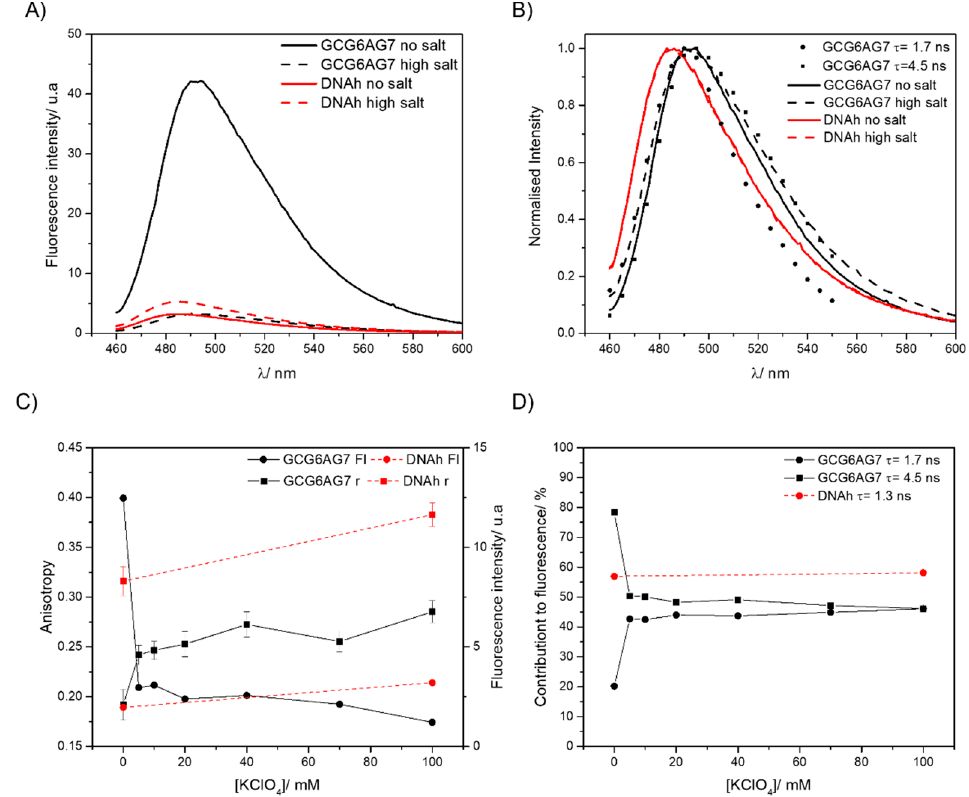
Figure 9. ( A ) Fluorescence emission spectra of ThT with GCG6AG7 and DNAh sequences in a Tris buffer in the absence of cations (solid lines) and with 100 mM potassium (dashed lines). ( B ) Normalized fluorescence emission spectra of graph A compared with the time-resolved emission spectra of the ThT species with τ = 1.7 ns and τ = 4.5 ns. ( C ) Steady-state fluorescence anisotropy (squares, left scale) and fluorescence intensity (circles, right scale) of ThT with GCG6AG7 (black symbols) and with DNAh (red symbols) sequences in a Tris buffer with different concentrations of potassium. ( D ) Percentage contributions to fluorescence of the two ThT species observed with GCG6AG7 (black symbols) and the one with DNAh (red symbols) in a Tris buffer with different concentrations of potassium.